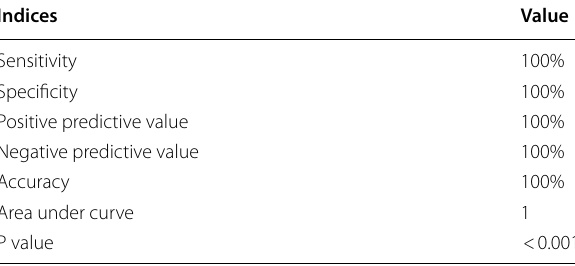
Table 4 Accuracy of Tru‑cut needle biopsy in identifying metastatic axillary lymph